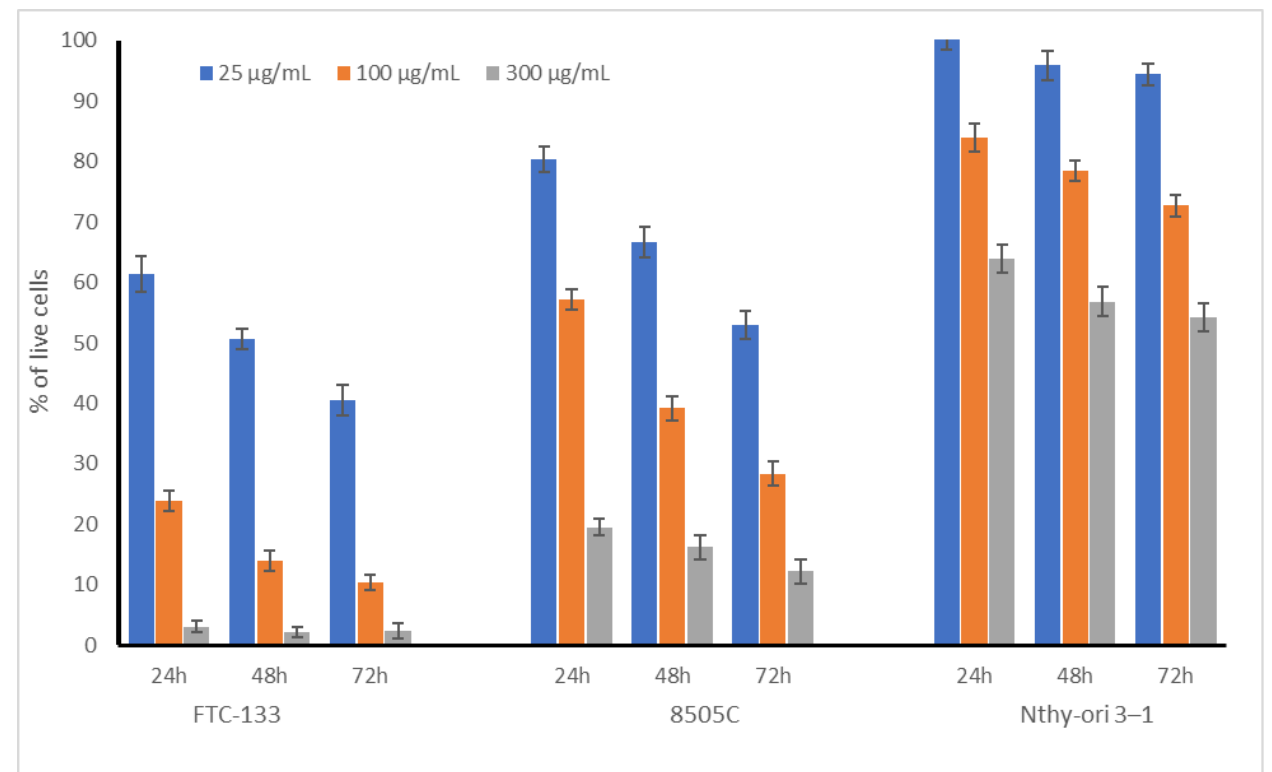
Figure 1. Cytotoxic effect of broccoli sprout extract (BSE) on cancer (FTC-133, 8505C) and non-neoplastic (Nthy-ori 3-1) thyroid cells. Cells were treated with 25, 100, and 300 µg/mL of sprout extract for 24 h, 48 h, and 72 h. Values are presented as the mean ± SD (standard deviation) (n = 3).